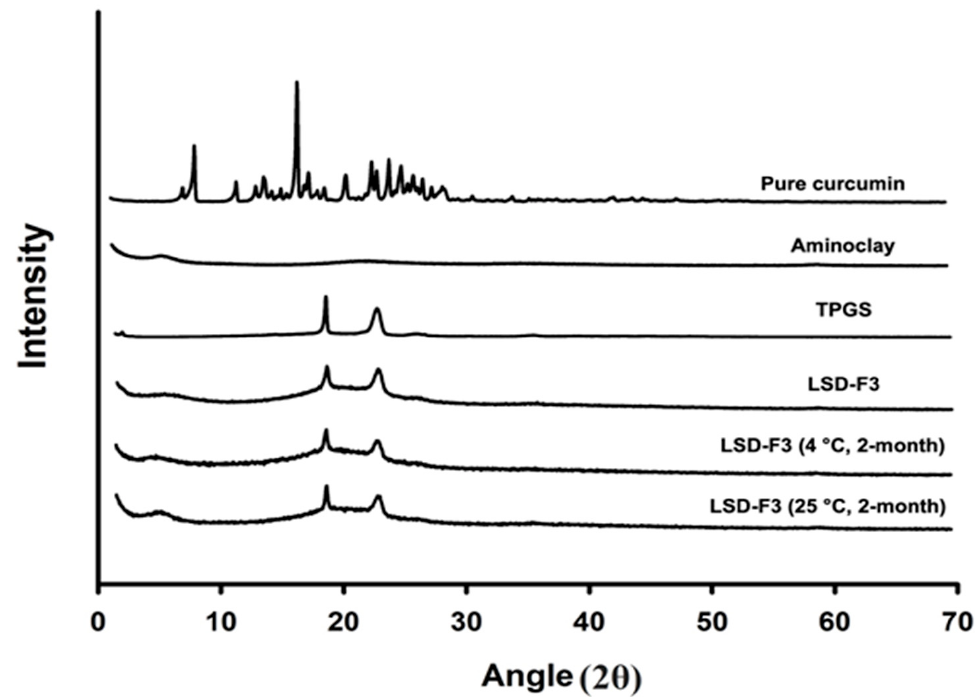
Figure 3. XRPD diffractograms of pure curcumin, formulation components, and LSD-F3 with/without 2-month storage at different temperatures.